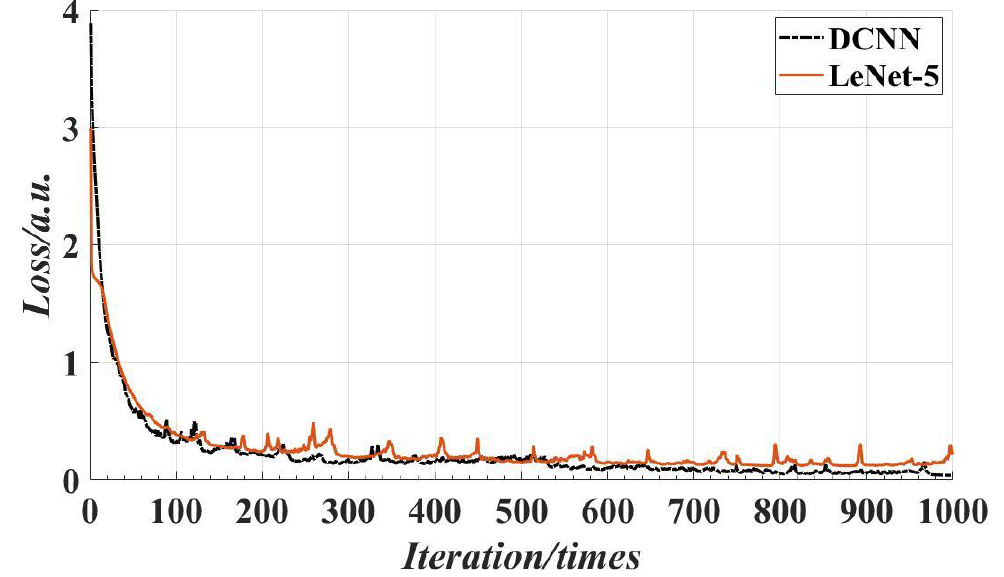
Figure 17. The minimum training loss of the two models with 1000 iterations.